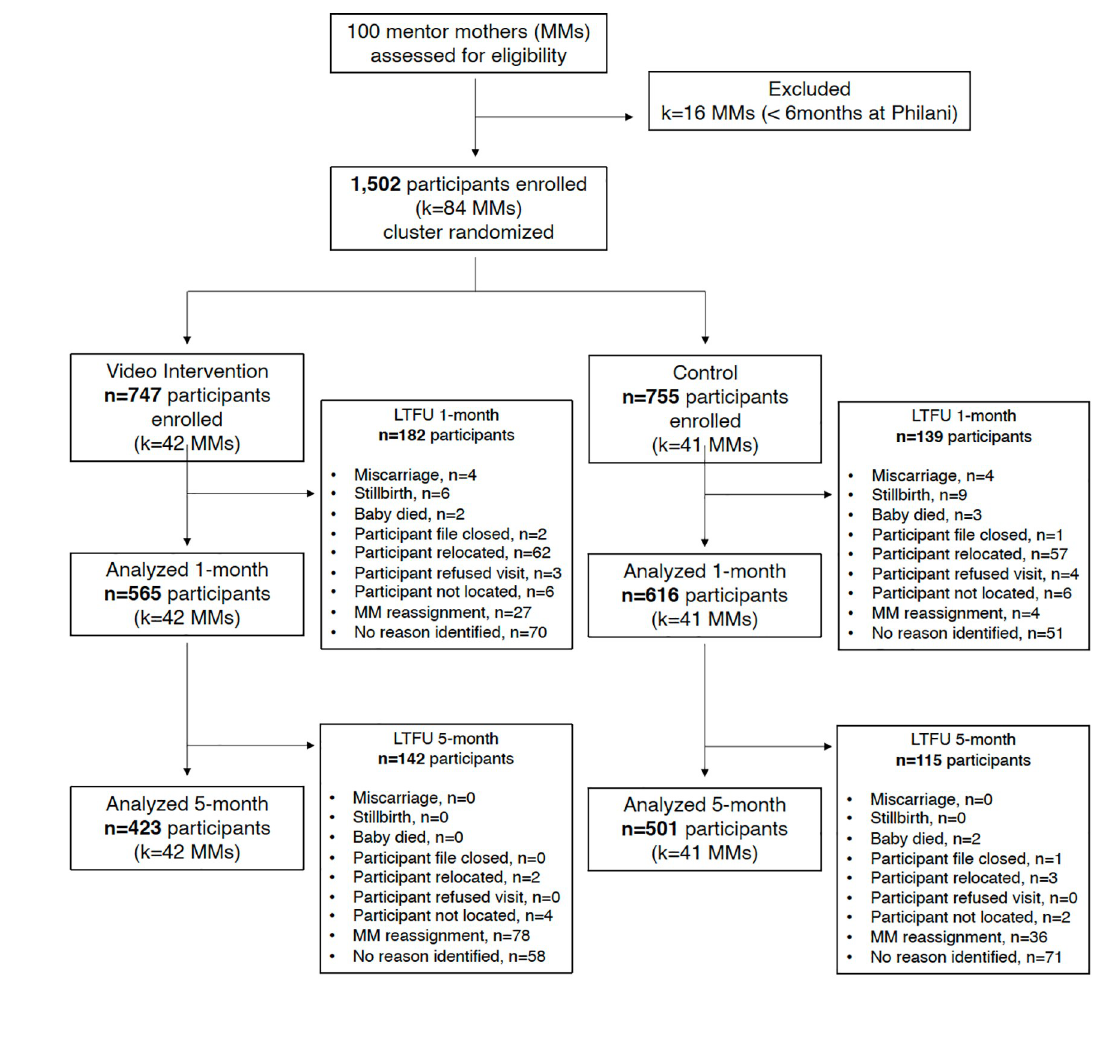
Fig 2. Participant flow diagram for the Philani MOVIE study. LTFU, loss to follow-up; MM, mentor mother; MOVIE, MObile Video Intervention for Exclusive breastfeeding.